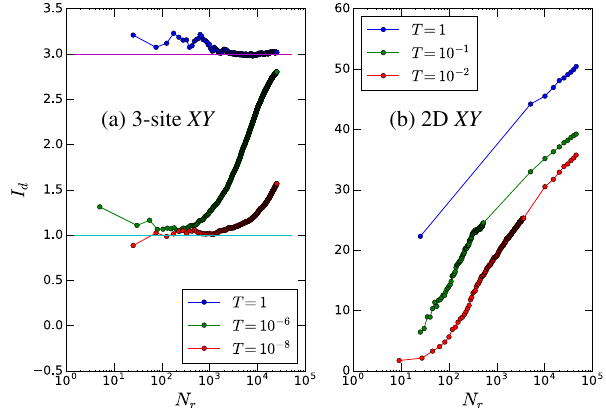
FIG. 12. Scaling of the I d with the number of configurations in the data set. In panel (a), we show the results for the three-site XY model, while in panel (b), we show results for the 2D XY model with L ¼ 10